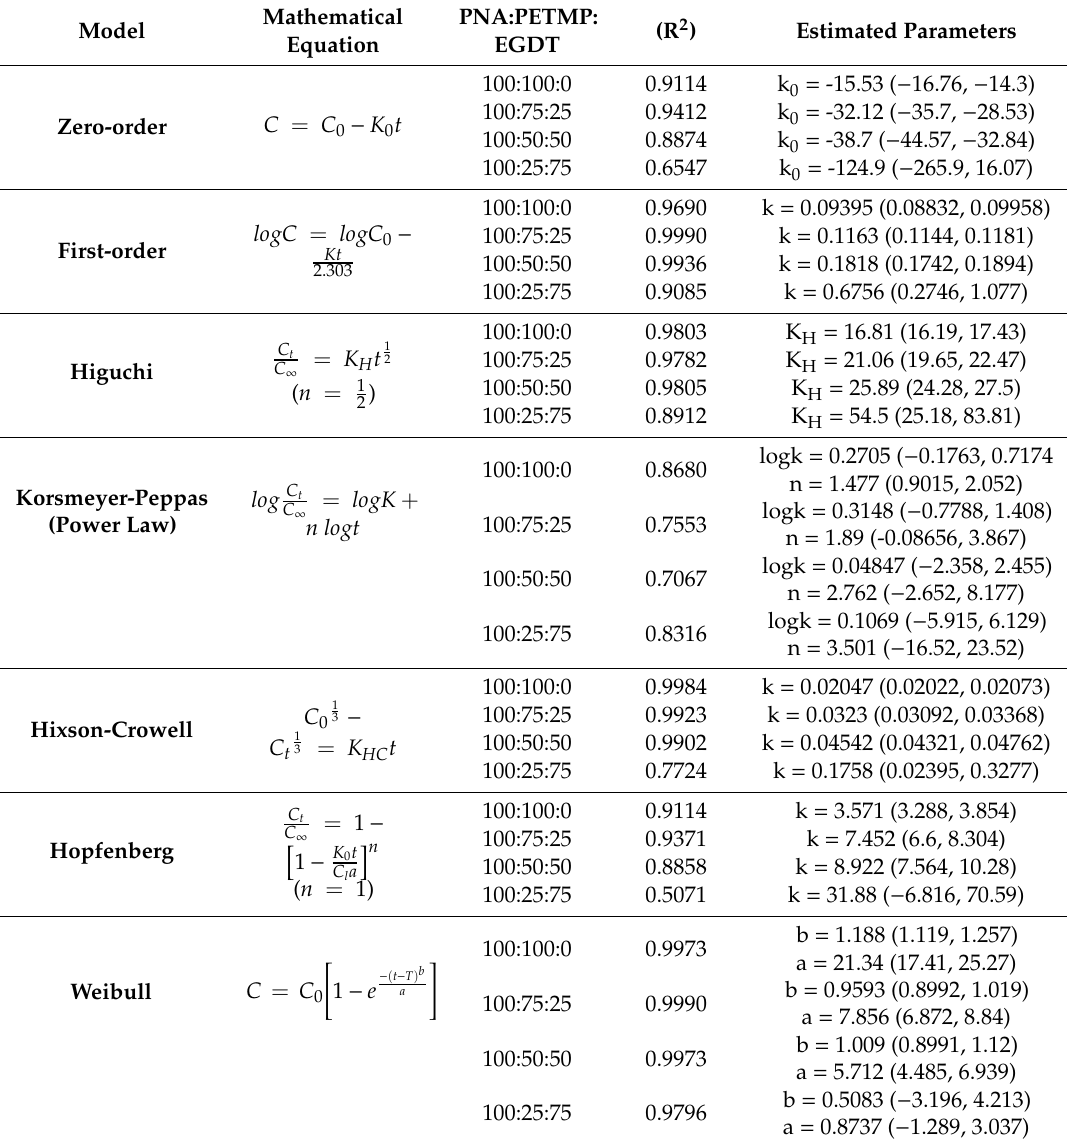
Table 3. Release kinetic models fitting for cuboid polymers. The models with their equations, mole ratios of monomers, R 2 , and derived parameters are shown in this